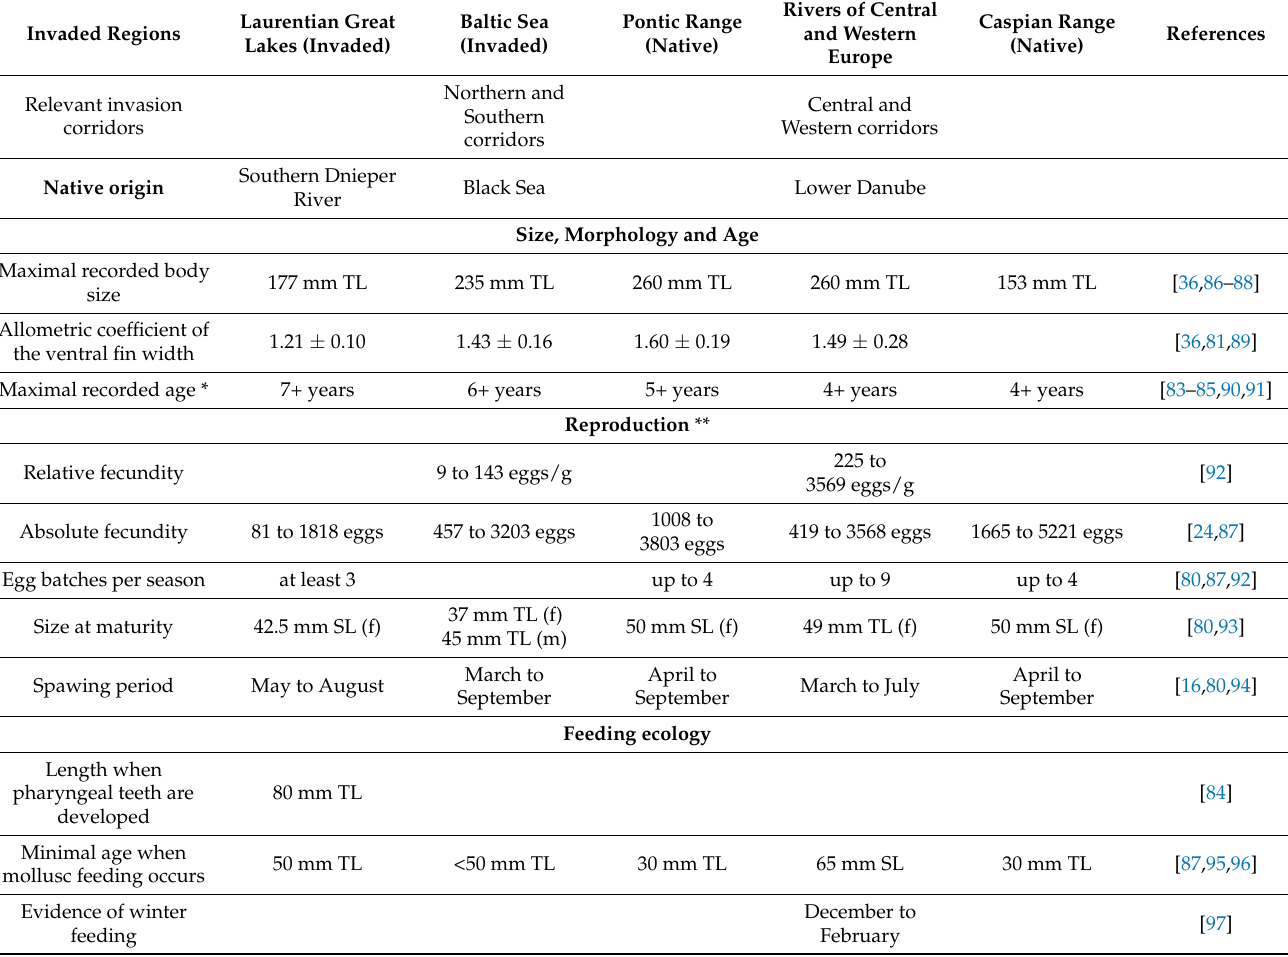
Table 1. Comparison of traits facilitating invasion and basic fish-biological data of round goby ( Neogobius melanostomus ) from various invaded and native regions in Europe and North America. Morphological, reproductive and feeding-specific traits are displayed